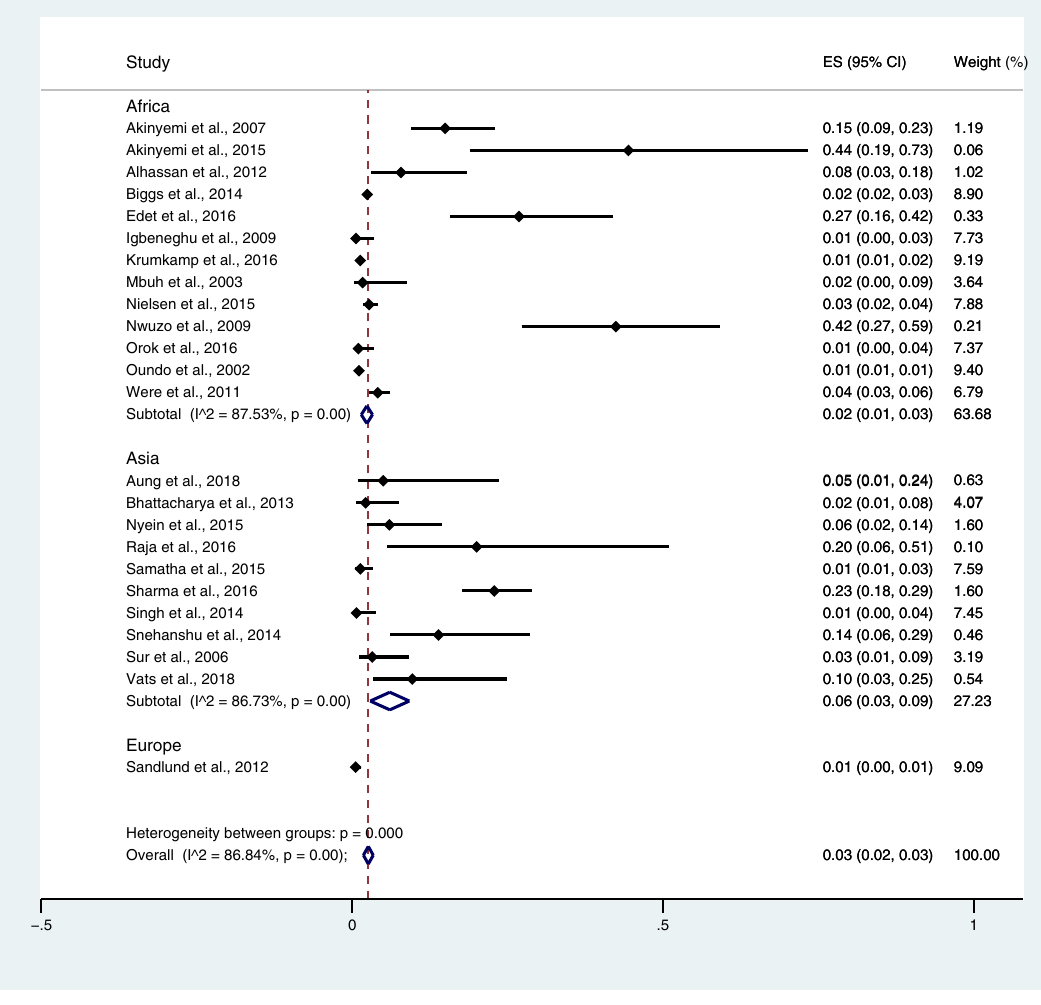
Figure 18. Prevalence of typhoidal/NTS infection among patients with malaria using blood cultures for the identification of Salmonella spp. infection stratified by regions. ES proportion estimate (multiply 100 units for interpreted as prevalence estimate), CI confidence interval, NS not